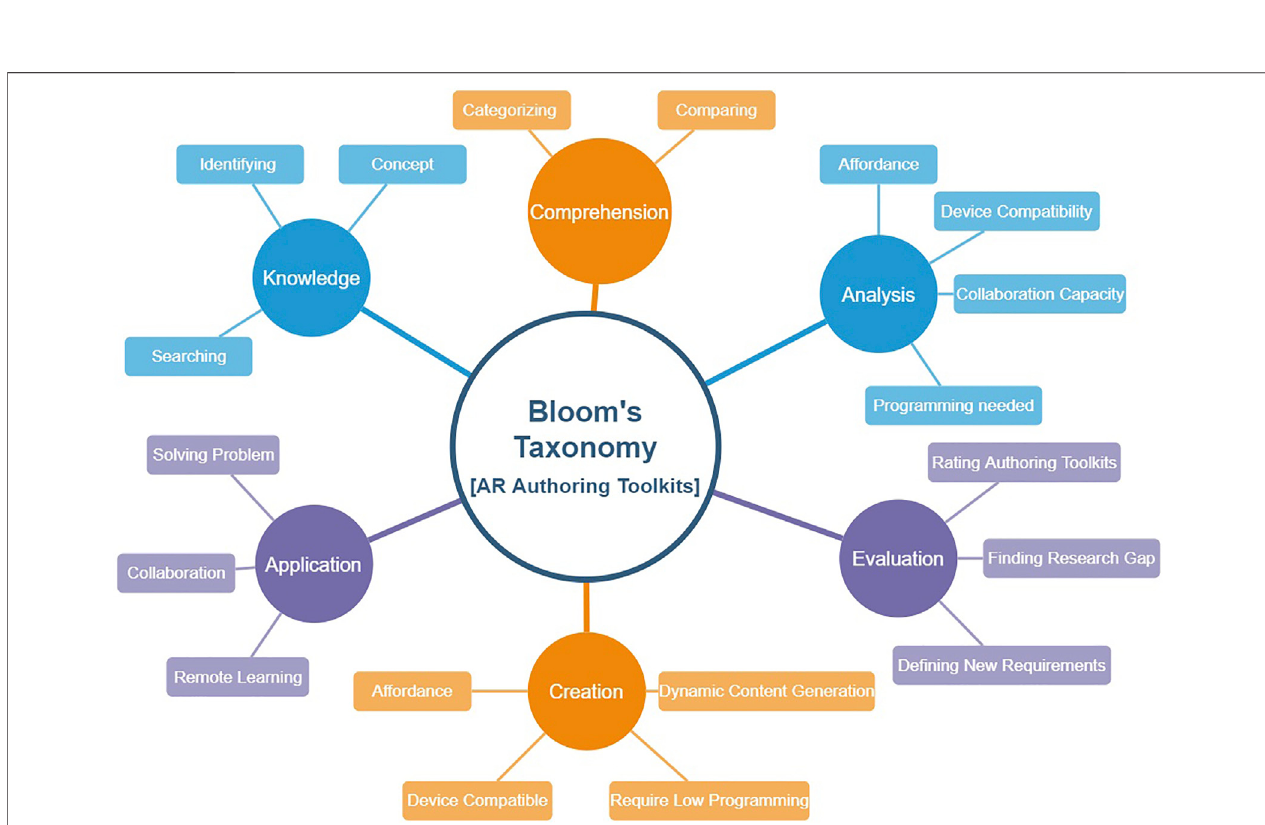
FIGURE 7 | Bloom ’ s Taxonomy; From existing work to future goal of the project.